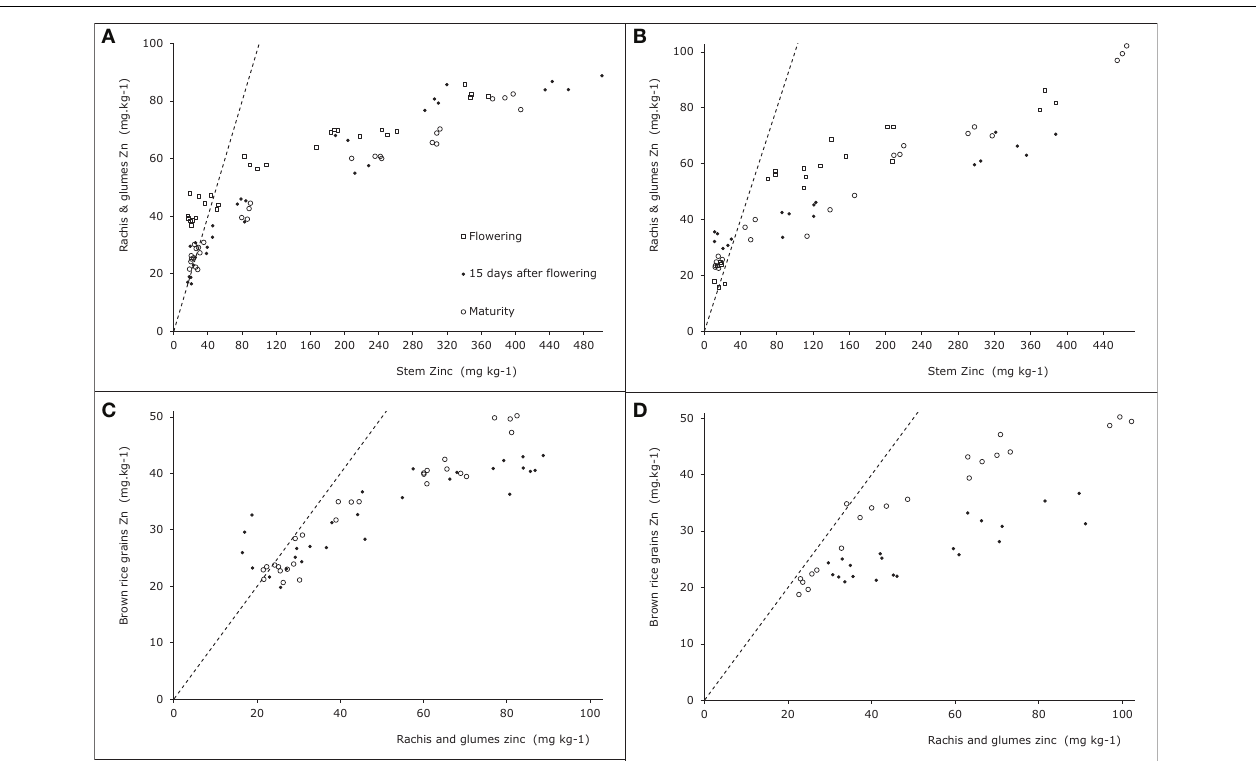
FIGURE 6 | Zinc concentrations in generative plant tissues as indicated along the y-axes for two rice genotypes tested in Experiment 4 [see also Jiang et al. (2008a)]. Panels (A) and (C) are for Baxiludao, Panels (B) and (D) for Handao 502. Data